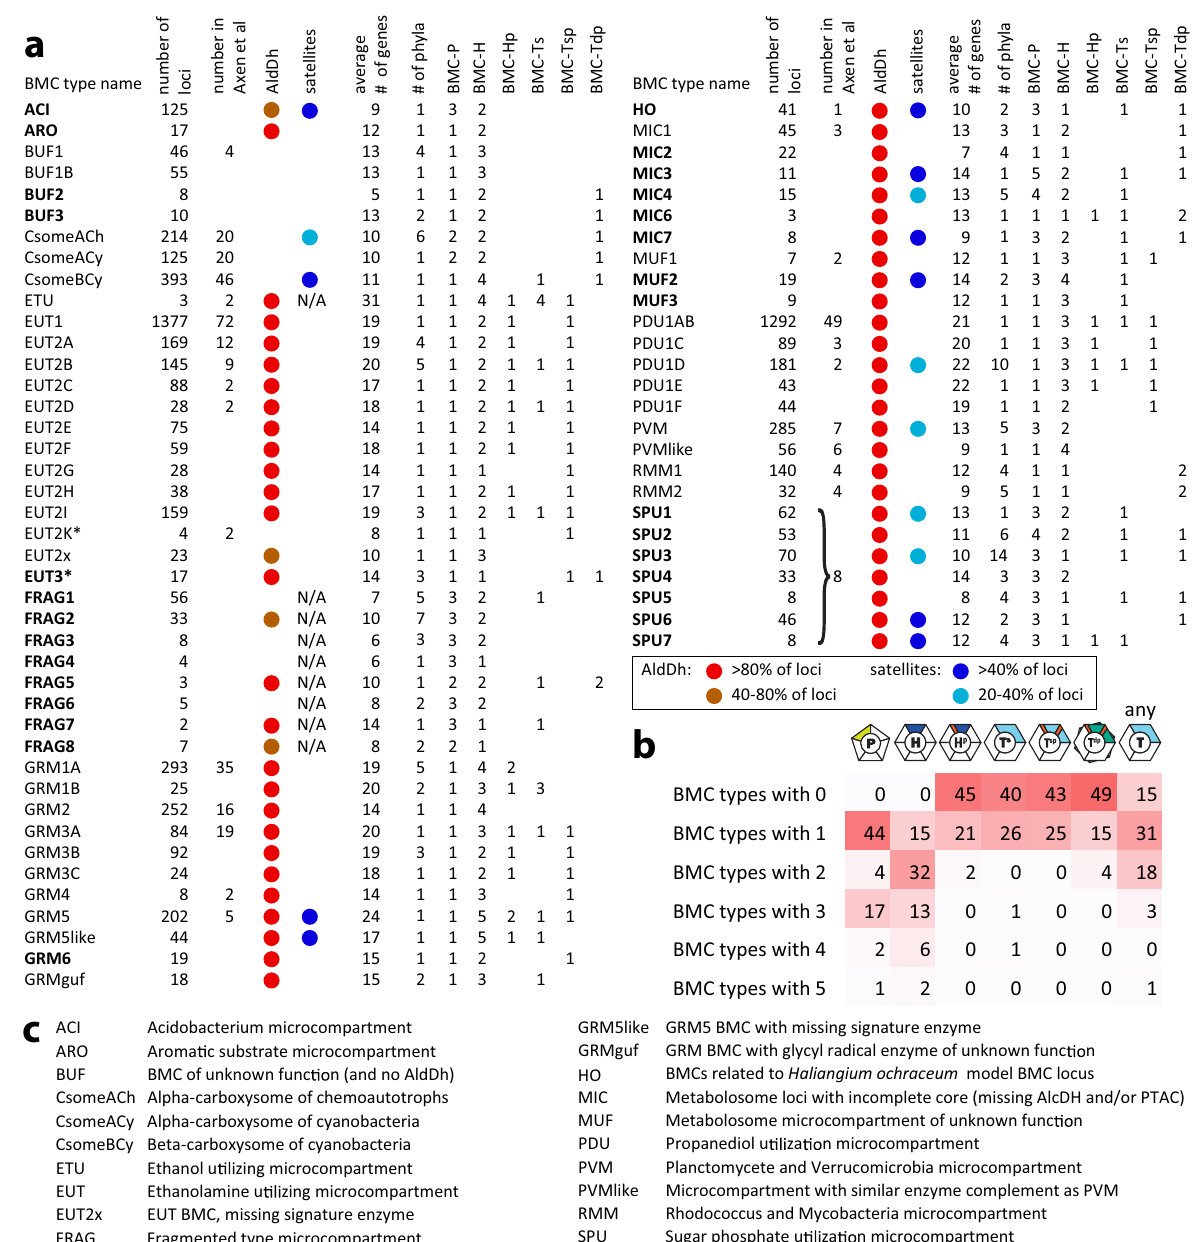
Fig. 2 Overview of BMC types and shell protein content found across all bacteria. a Table of number of loci for each BMC type in this study and in Axen et al. 4 , AldDh occurrence, the prevalence of satellite loci, the average number of genes in the locus, number of observed phyla, and number of each type of shell protein. Major new BMC types or subtypes identi fi ed in this study in bold. The asterisk denotes the name change of EUT3 (Axen et al. 4 ) to EUT2K because the present analysis indicates EUT2K is not a major new type. b Numbers of each type of shell protein across BMC types. c Explanation of BMC type